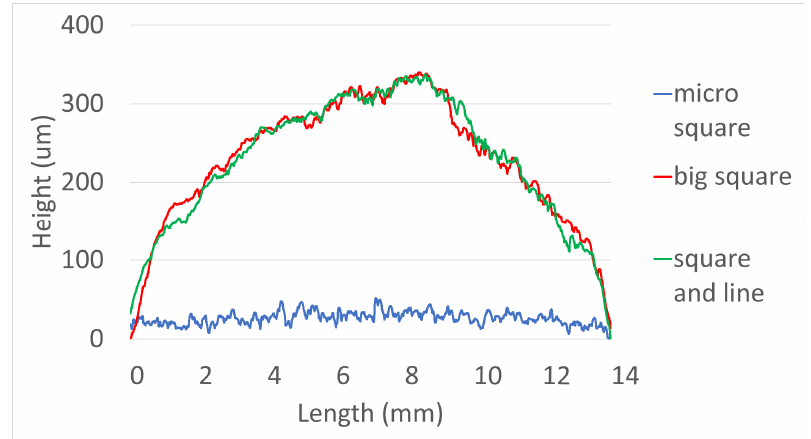
Figure 18. Surface pro fi le—Green body specimens according to various pa tt erns.